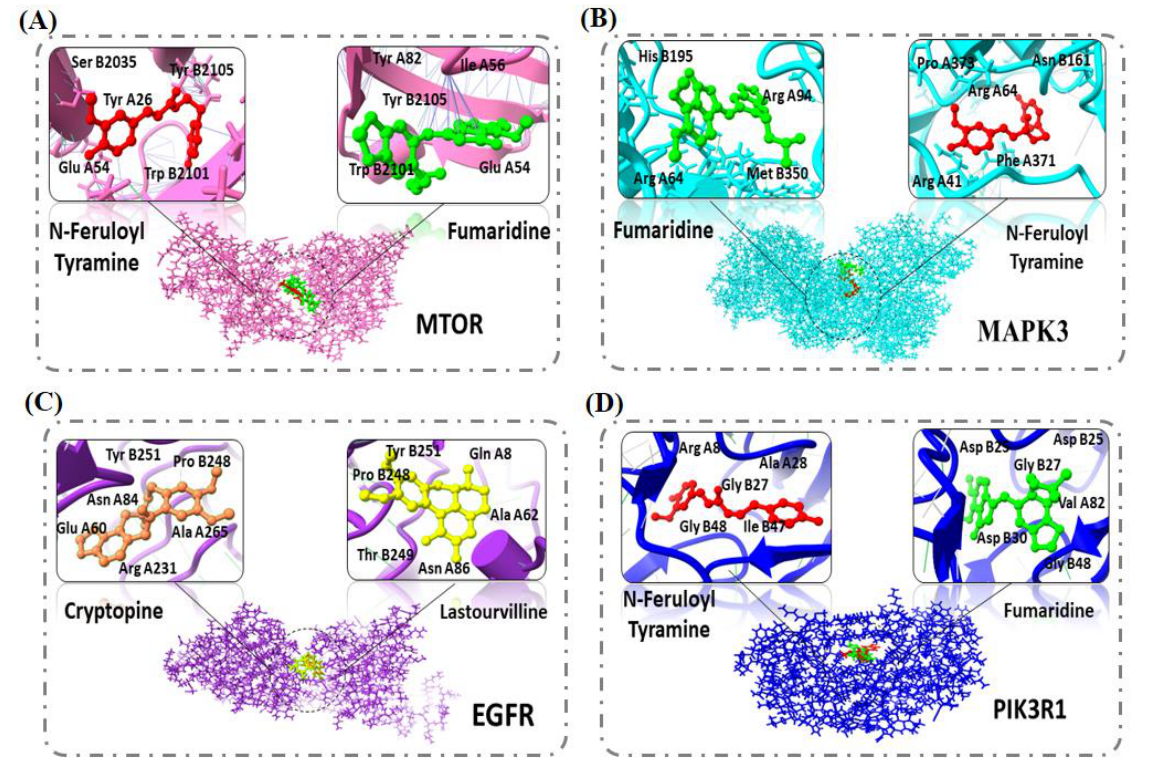
Figure 4. Represents the sketch maps of target proteins together with their strongest binding compo- nents. ( A ) MTOR, ( B ) MAPK3, ( C ) EGFR, and ( D )